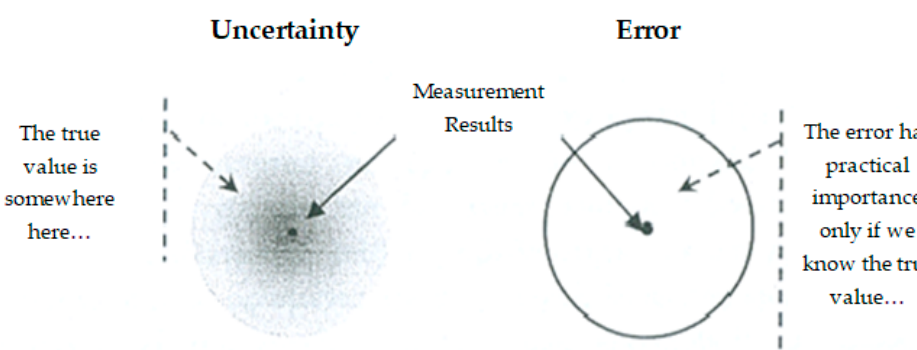
Figure 3. Difference between uncertainty and error.